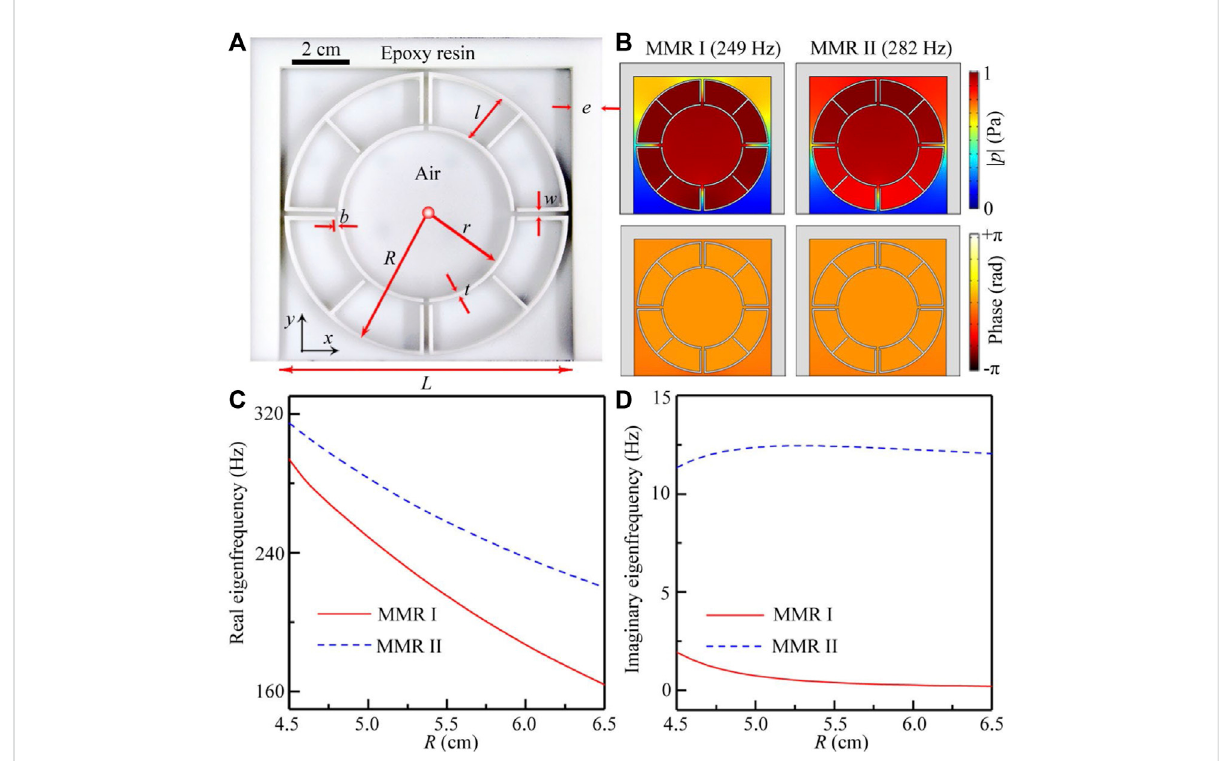
FIGURE 1 (A) Photograph of theunit cell of Mie resonance. (B) Simulated pressure and phase eigenfunctions of theunit cell with R = 5.0 cm. Eigenmodes of MMR I and II can be observed at 249 and 282 Hz, respectively. (C) Real and (D) imaginary parts of the eigenfrequencies for MMR I and II with different values of R